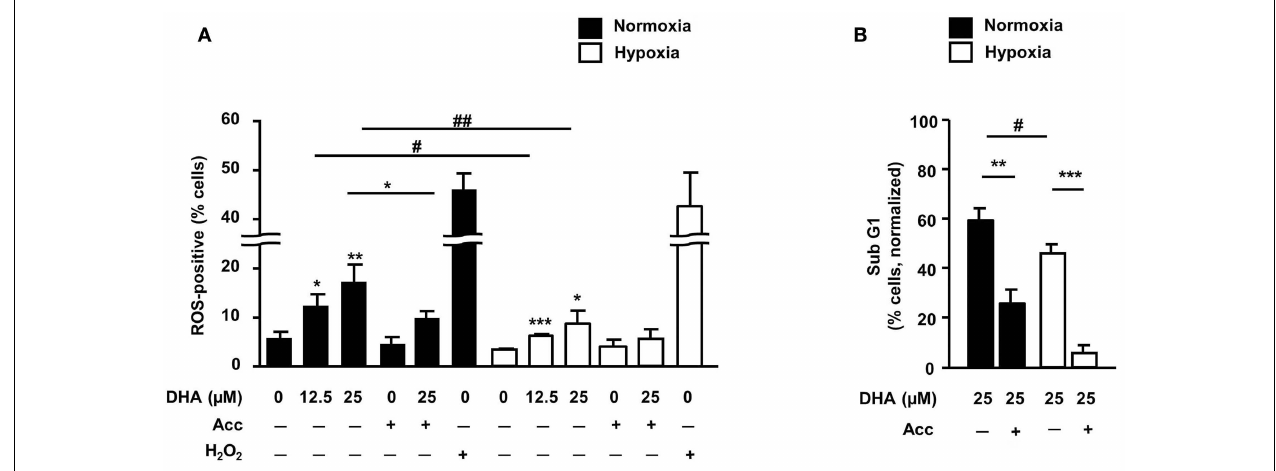
FIGURE 5 | ROS are important mediators of DHA-induced cytotoxicity in both, normoxia and hypoxia . (A,B) HCT116 cells were pre-incubated for 30min in the absence or presence of the radical scavenger N -acetylcystein (Acc; 2mM) and then treated for 24h (A) or 48h (B) with DHA (0–25 µ M) under normoxic and hypoxic conditions as indicated. (A) DHA induces ROS under normoxic and hypoxic conditions in a concentration-dependent manner. Treatment with 250 µ M H 2 O 2 for 2h was applied as a positive control for ROS formation. Pre-treatment with the ROS scavenger N -acetylcystein (Acc)